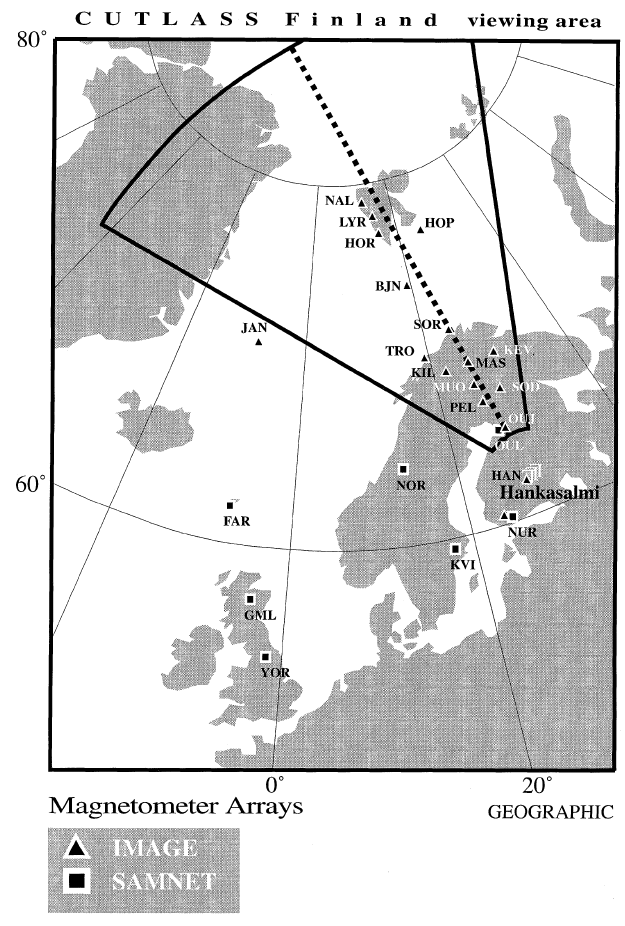
Fig. 1. Locations of the field-of-view of the CUTLASS Finland radar together with the IMAGE and SAMNET magnetometer stations used in this study. Beam 9 of CUTLASS Finland, which is sampled at a high rate, is marked by a dashed